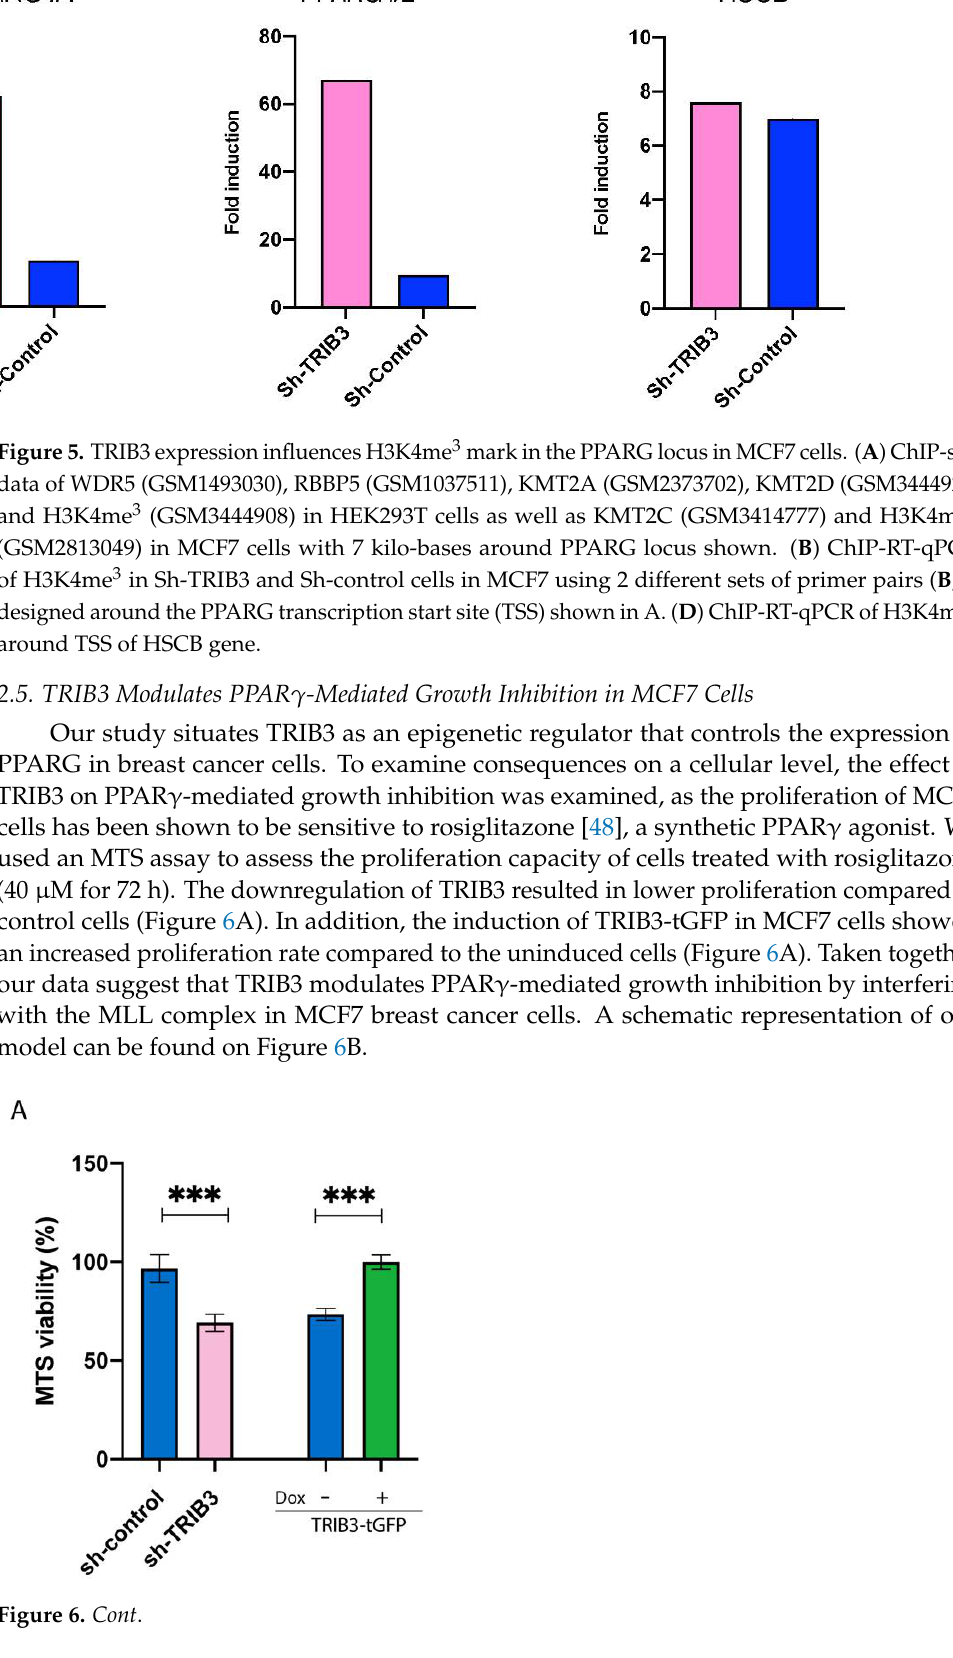
Figure 6. TRIB3 levels affects the sensitivity of MCF7 cells to TZD treatment. ( A ) Sh-control, shTRIB3 and TRIB3-tGFP-inducible MCF7 cells were treated for 72h with rosiglitazone at 40 μ. TRIB3-tGFP- inducible cells were treated with or without doxycycline for 24h before cell viability was measured. Data are indicated as mean  SEM. p -values were calculated using two-tailed Student’s t -test *** p  0.001) ( B ) Schematic representation of the role of TRIB3 as an epigenetic regulator. 3. Materials 3.1. Cell Culture Human embryonic kidney cell line (HEK293T, ATCC CRL-3216, Manassas, VA, USA) and human breast cancer cells (MCF7, ATCC HTB-22) were maintained in high- glucose (d-glucose, 4.5 g/L) Dulbecco’s Modified Eagle Medium (DMEM) supplemented with 10% fetal bovine serum and 1% penicillin and streptomycin. An inducible TRIB3- tGFP MCF7 cell line was generated using third-generation lentiviral constructs as de- scribed extensively previously [13]. TRIB3 knock-down and the control cell line in MCF7 cells have been described previously [39]. 3.2. Western Blotting Western blotting was performed as described previously [49]. In short, samples were treated accordingly and protein samples were extracted in RIPA lysis buffer. Protein con- centration was measured and samples were supplemented with Laemmli sample buffer (Sigma-Aldrich, Saint Louis, MO, USA) and loaded into 10–15% acrylamide gels. Samples